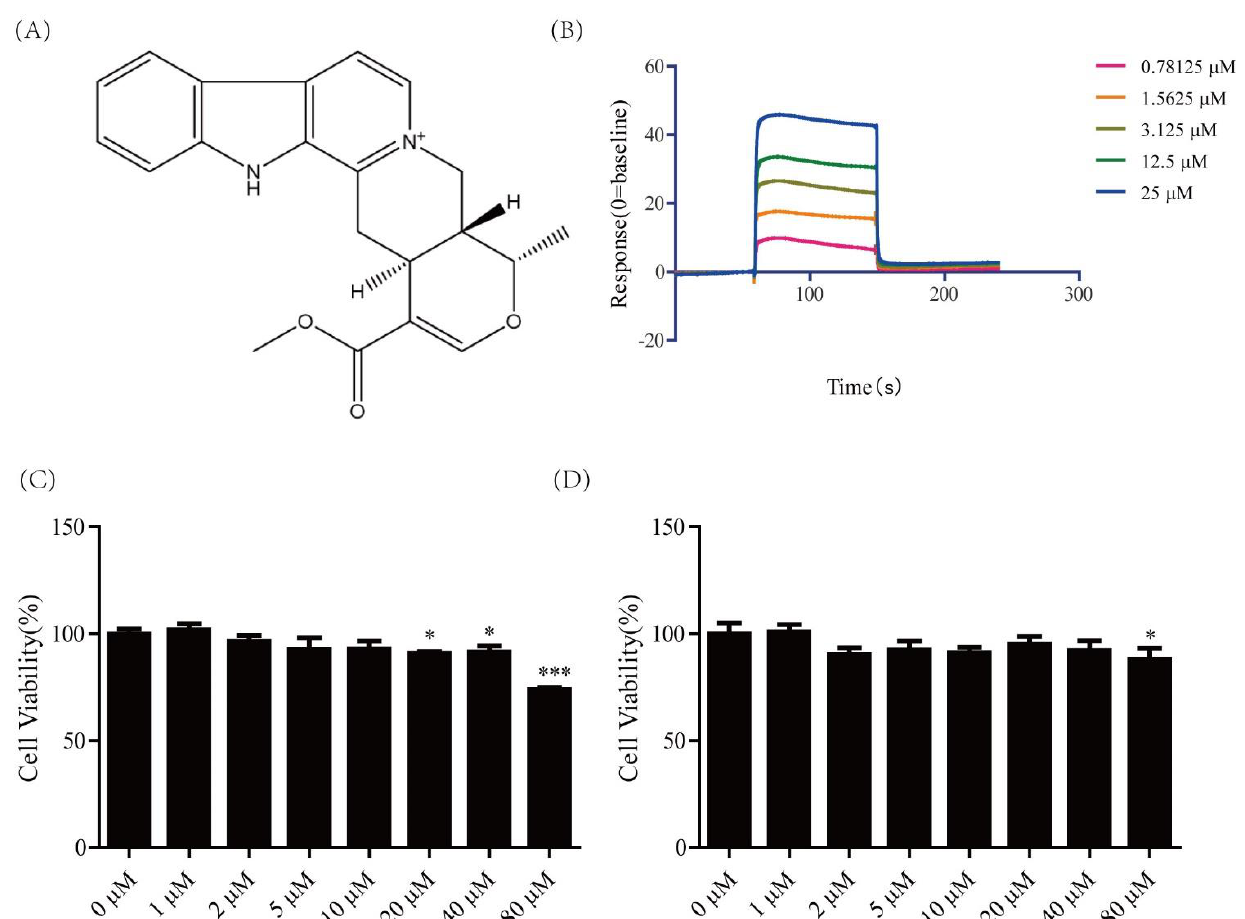
Figure 1. Cytotoxicity of serpentine and affinity of serpentine for the insulin receptor. ( A ) Chemical structure of serpentine. ( B ) Affinity of serpentine for the insulin receptor. ( C ) Cytotoxicity of serpentine against 3T3-L1. ( D ) Cytotoxicity of serpentine against C2C12. Data are expressed as means ± SEM ( n = 6 in each group). * p < 0.05, *** p < 0.001 versus 0 μM group.